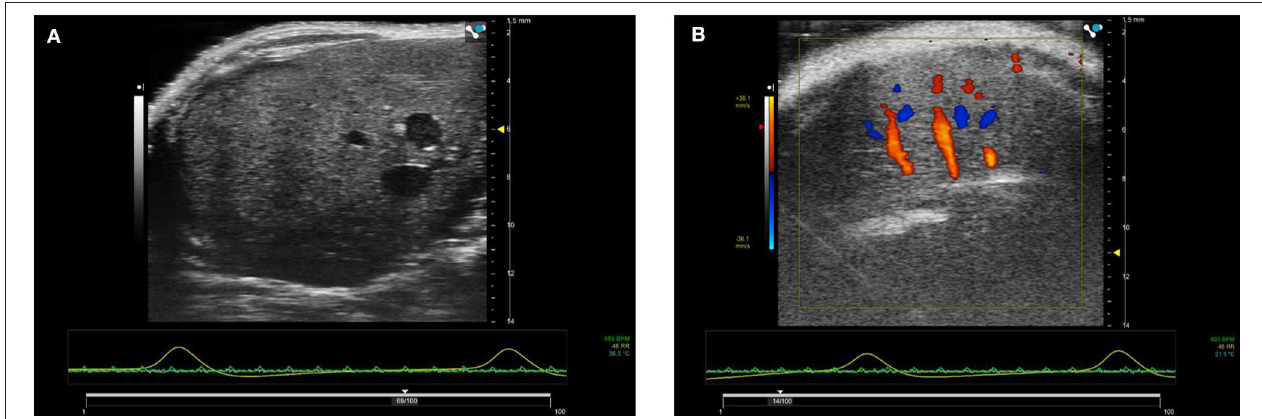
FIGURE 15 | (A) B-mode image of right lobe of normal mouse liver. Imaged using 40 MHz probe. (B) Color Doppler image of liver showing hepatic blood flow within the